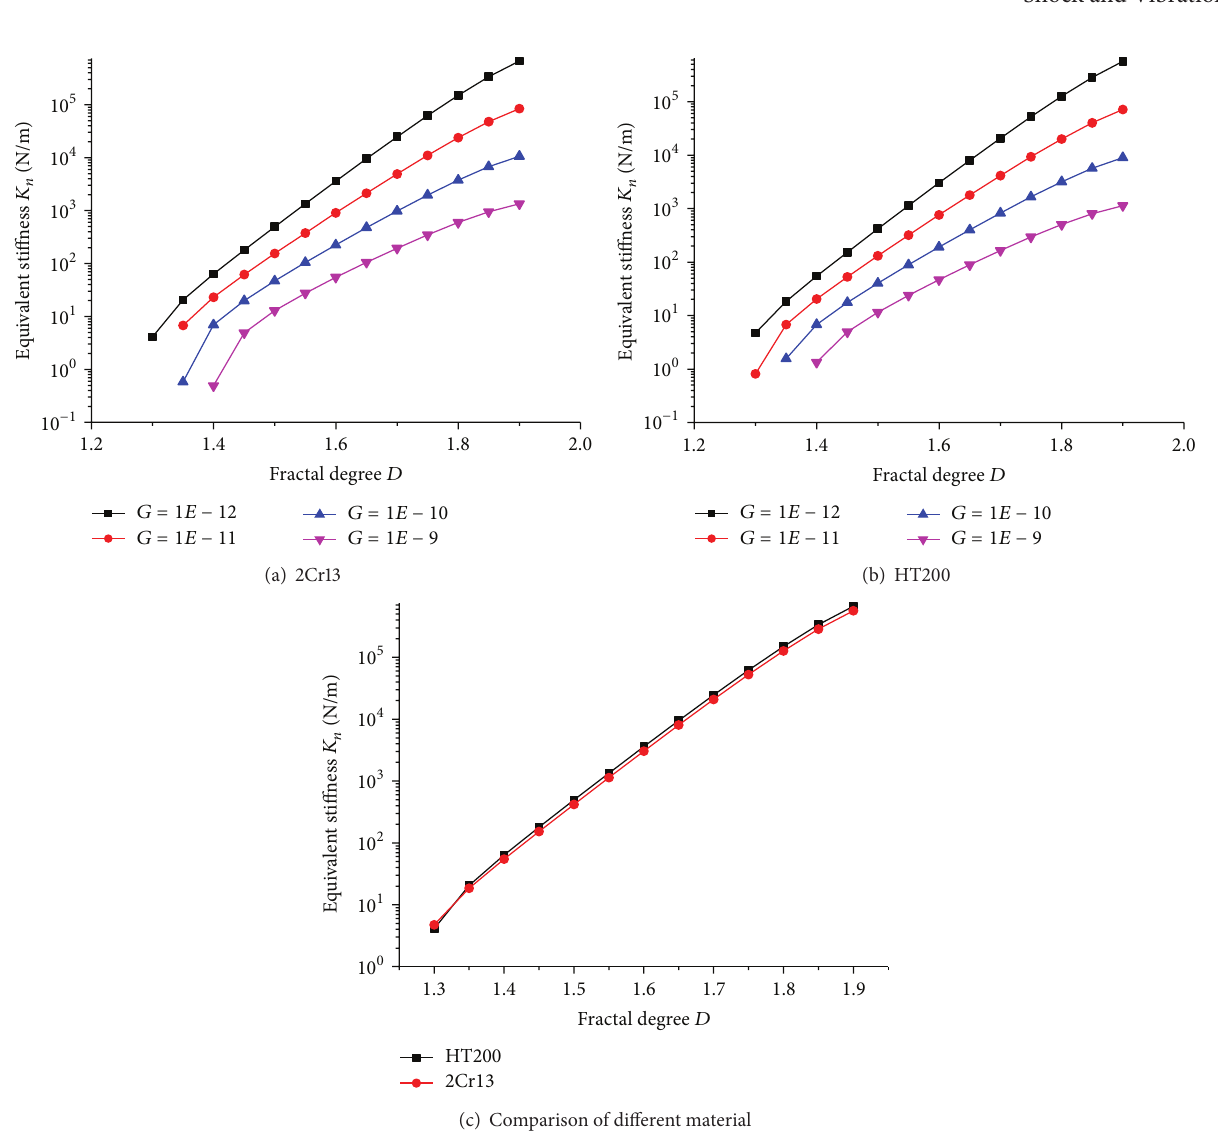
Figure 5: Relationship of equivalent stiffness with fractal degree 𝐷